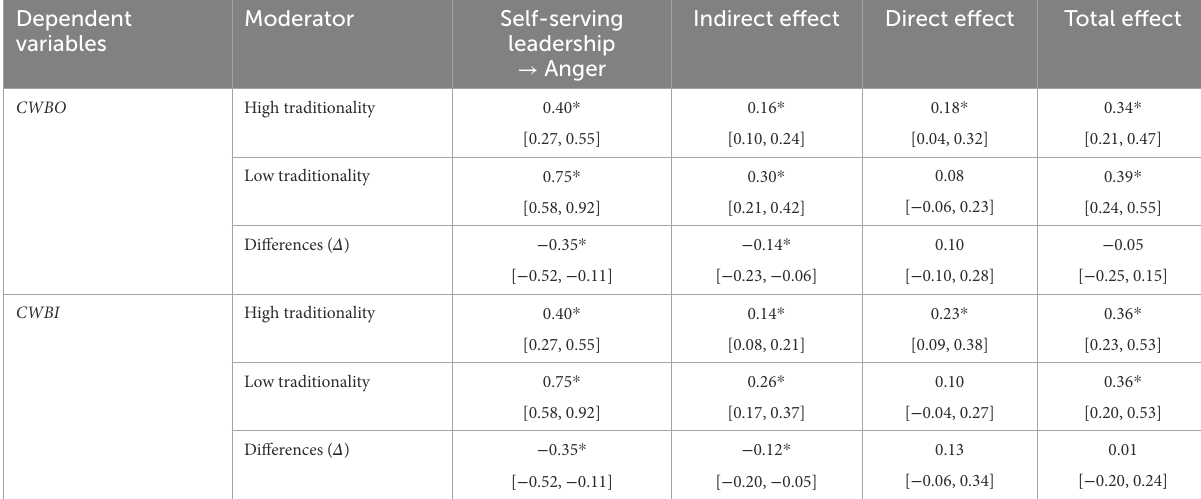
TABLE 4 Results of moderated mediation